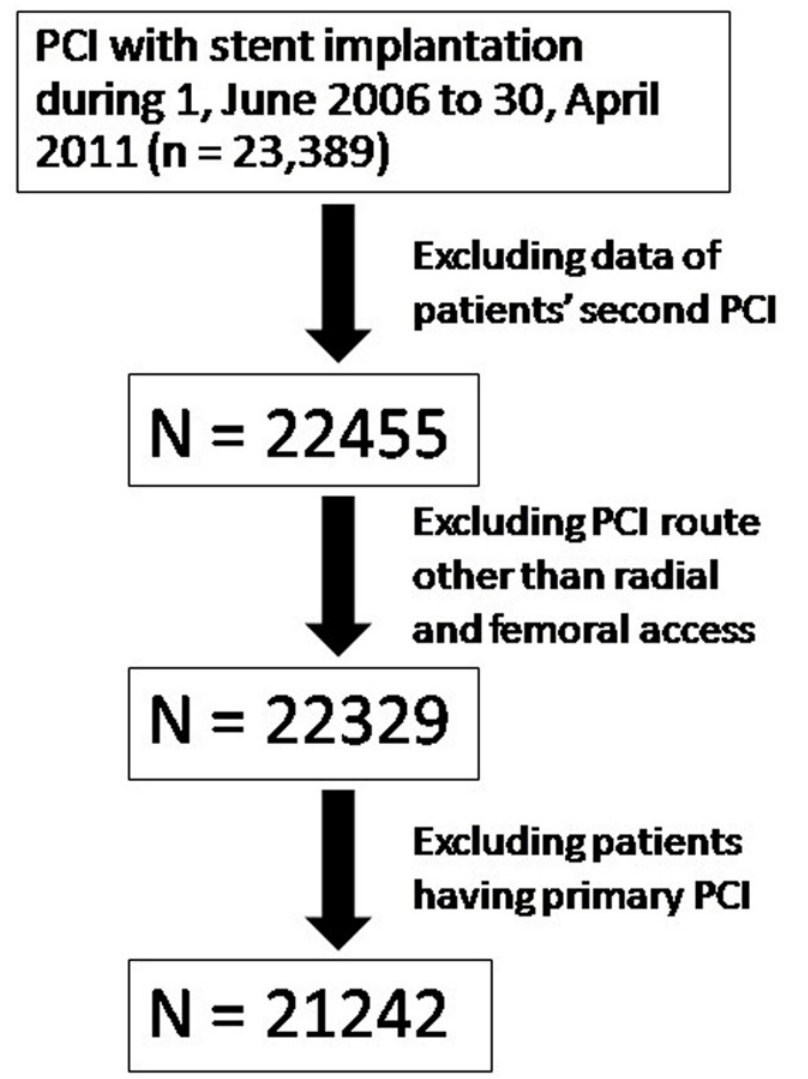
Fig 1. The flow chart of patient